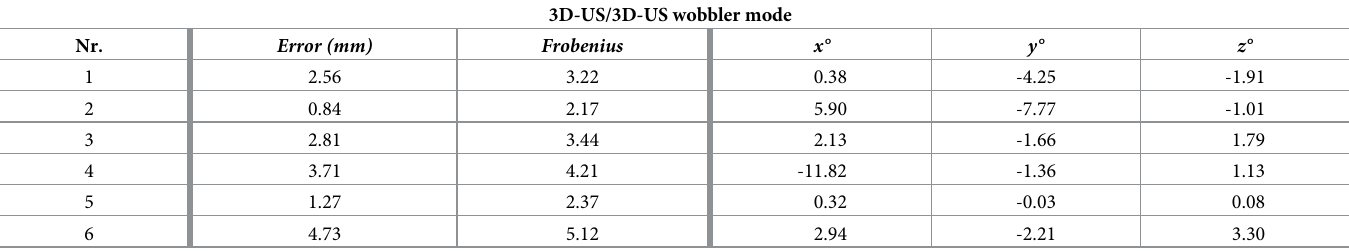
Table 5. Registration error arising with patient data for the 3D wobbler mode . Orientations/angles (degrees) are relative to the axes of the reference position of the trans- ducer given with the first reference scan.